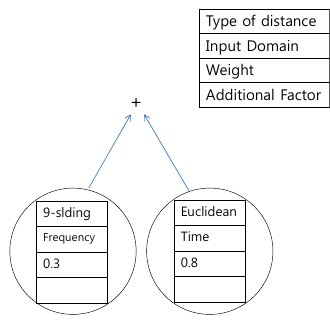
Figure 14. Example tree of genetic programming. The presented distance measure is the sum of the k- sliding distance in the frequency domain with a weight of 0.3 and the Euclidean distance in the time domain with a weight of 0.8.